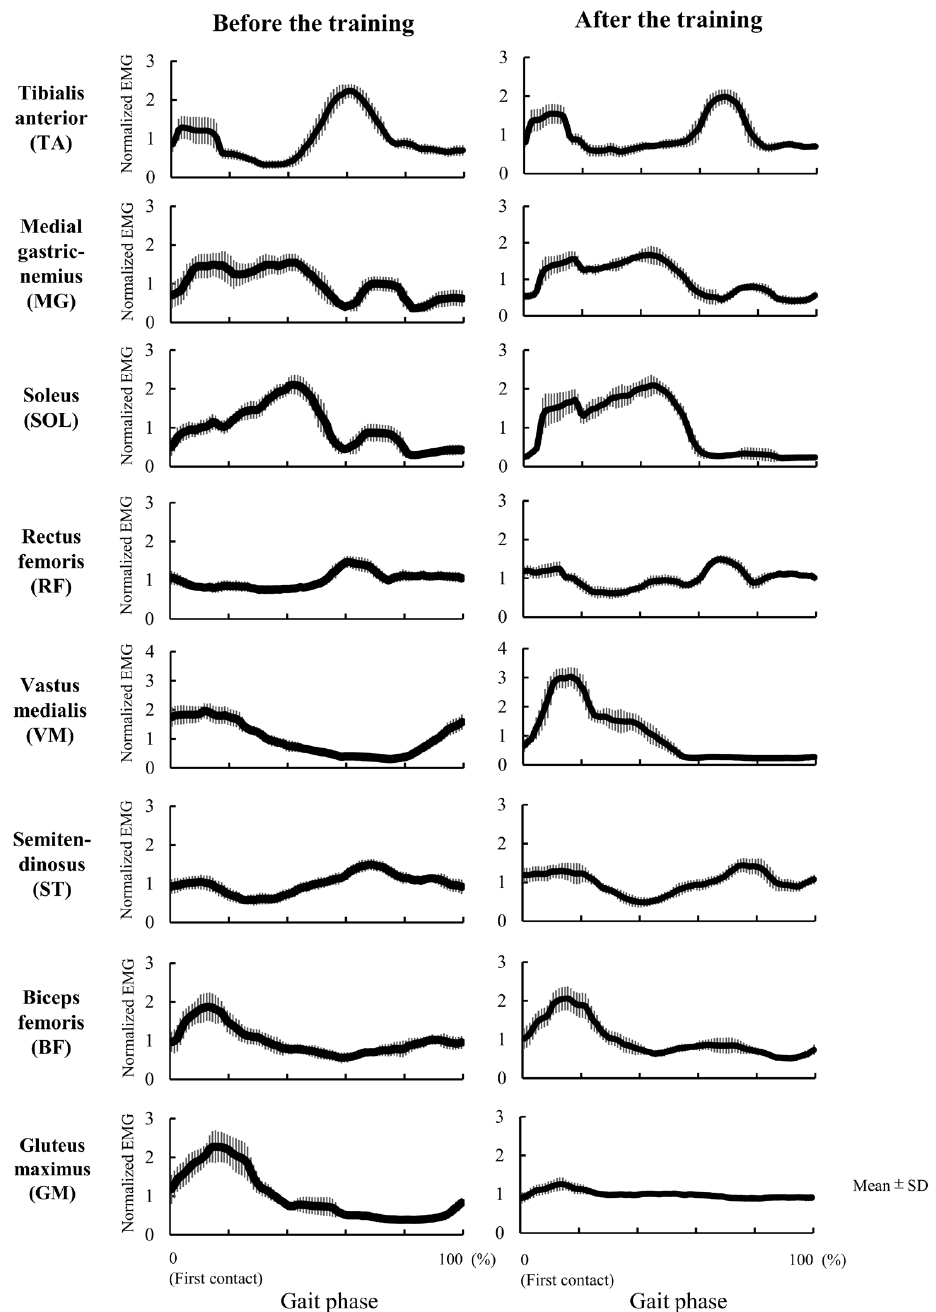
Figure 3. Electromyography (EMG) on the affected side during gait before and after nine days of robot-assisted gait training. Graphs indicate normalized electromyography (EMG) during barefoot overground walking before ( left ) and after training ( right ). The horizontal axis indicates one gait cycle, with 0% indicating initial foot contact on the affected side and 100% indicating the next contact. The thick solid line represents the mean normalized EMG, and the thin vertical line represents the standard deviation. We assessed eight muscles: the tibialis anterior muscle, the medial gastrocnemius muscle, the soleus muscle, the rectus femoris muscle, the vastus medialis muscle, the semitendinosus muscle, the biceps femoris muscle, and the gluteus maximus muscle. After the training, the genu recurvatum disappeared, and the activity of the vastus medialis muscle increased in the early stance phase.